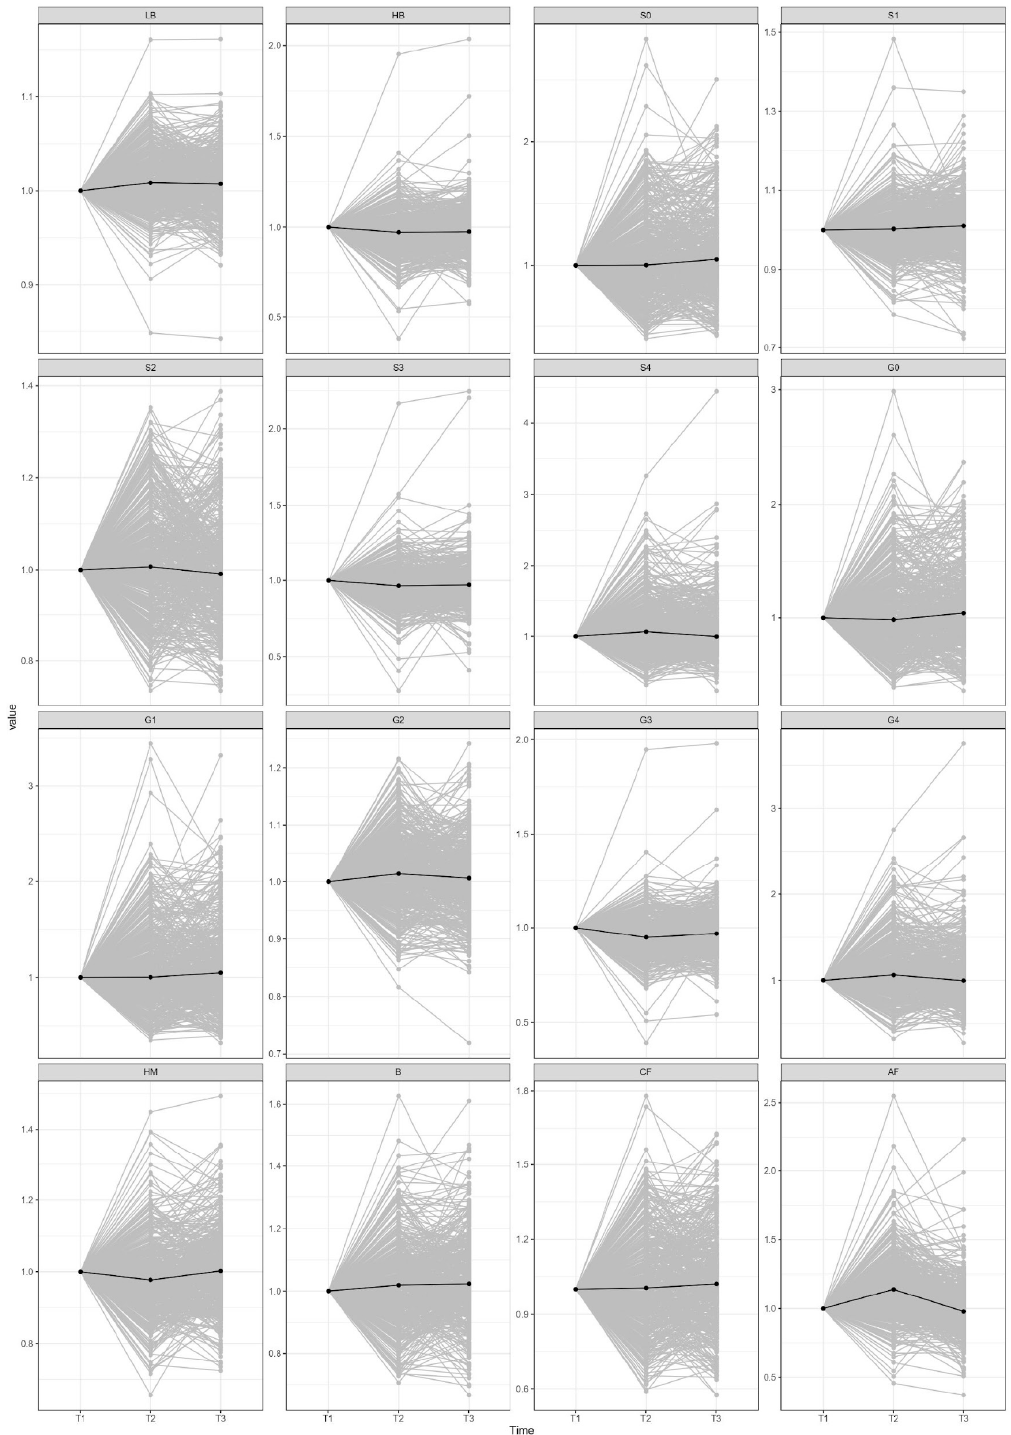
Figure 3. Changes in plasma N-glycome composition between different time-periods. Presented glycome changes are normalized to the first point. T1—time point 1; T2—time point 2; T3—time point 3; LB—total low branching glycans; HB—total high branching glycans; S0—total neutral glycans; S1— total monosialylated glycans; S2—total disialylated glycans; S3—total trisialylated glycans; S4—total tetrasialylated glycans; G0—total agalactosylated glycans; G1—total monogalactosylated glycans; G2—total digalactosylated glycans; G3—total trigalactosylated glycans; G4—total tetragalactosy- lated glycans; HM—total high-mannose glycans; B—total glycans with bisecting GlcNAc; CF—total glycans with core fucose; AF—total glycans with antennary